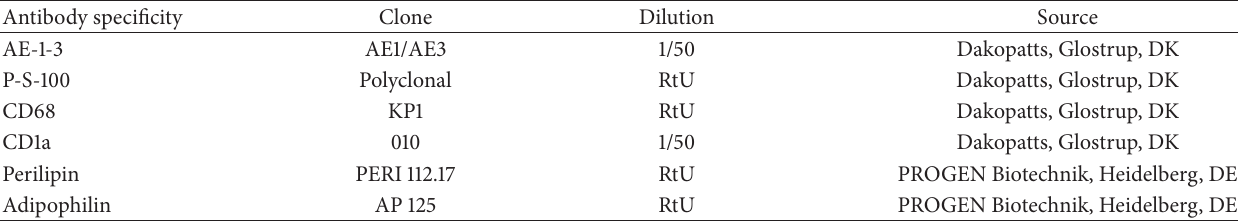
Table 1: Antibodies used in the immunohistochemical